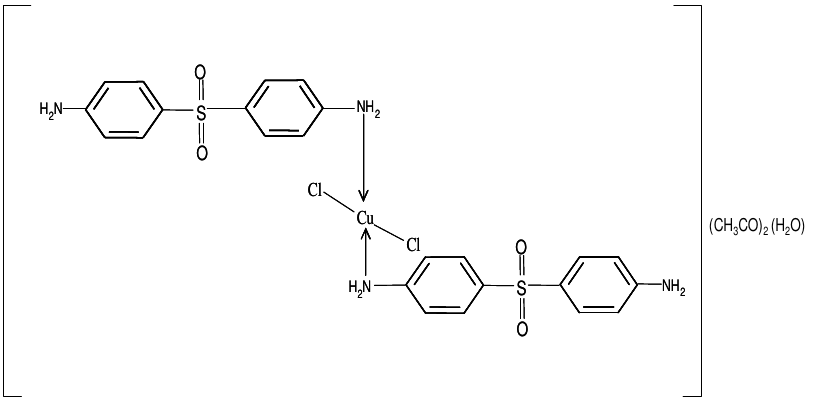
Cl ] (H O)(CH CO) 2 2 2 3